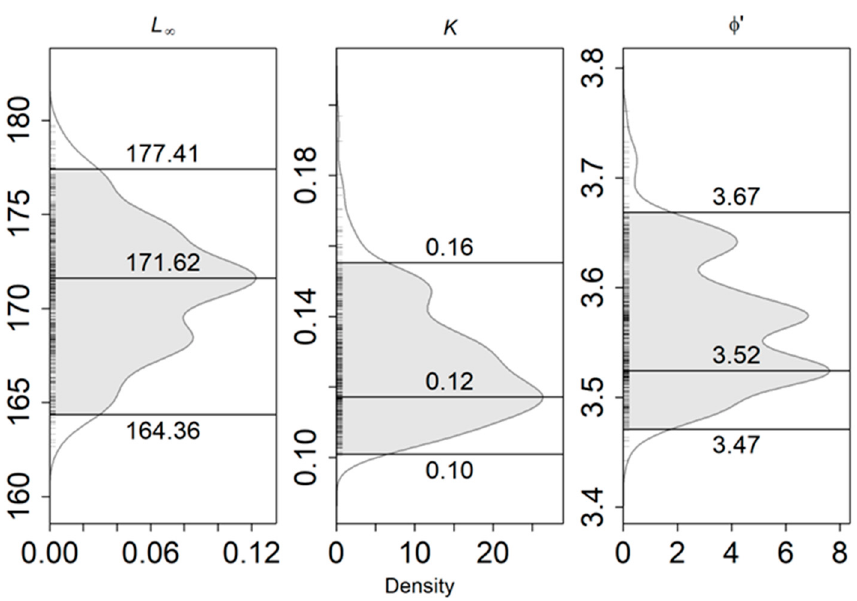
Figure 7. Growth parameters’ estimates for pooled sexes, with 0.95 confidence intervals for Lepidopus caudatus in the Azorean waters from official landings data (2010–2017). L ∞ represents the asymptotic length (cm), k is the growth coefficient (year − 1 ) and Φ ’ is the growth performance index.